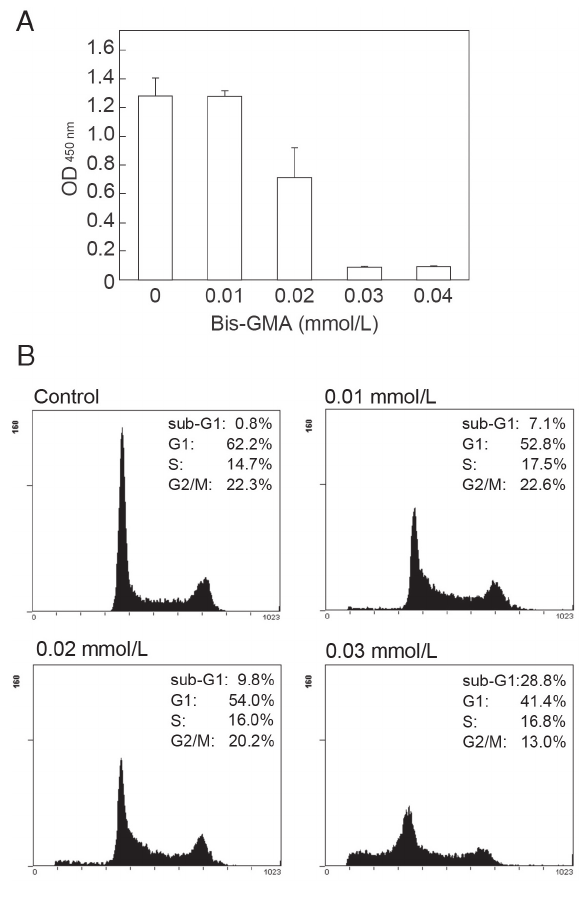
Figure 1- Cytotoxic effects of 2, 2-bis [4-(2-hydroxy-3- methacryloxypropoxy) phenyl] propane (Bis-GMA) on LSC2 cells. (A). Viability of LSC2 cells after exposure to Bis-GMA. (B). Cell cycle of LSC2 cells after exposure to